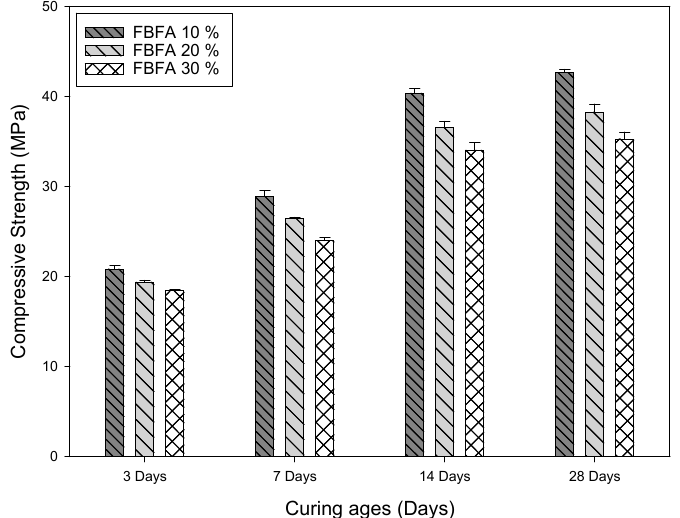
Figure 2. The compressive strength of different percentages of the fluidized bed fly ash (FBFA) in the AAMs bricks.